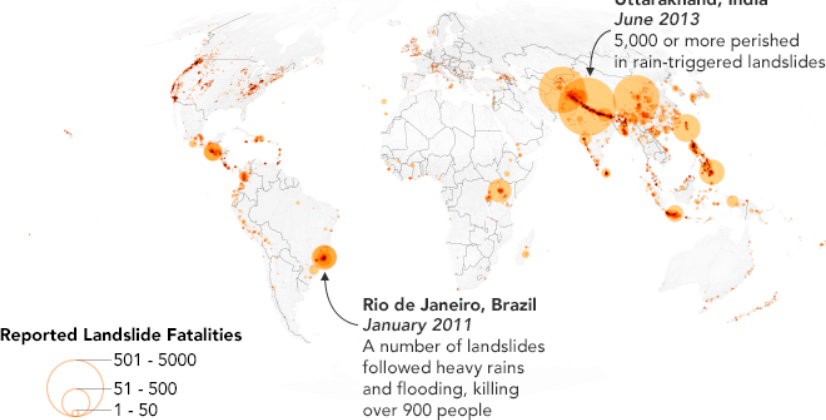
Figure 10. Map of 2085 landslides with fatalities as reported in the Global Landslide Catalog. Courtesy of NASA Earth Observatory, using landslide susceptibility data provided by T. Stanley and D. Kirschbaum (https://pmm.nasa.gov/articles/help-create-largest-landslide-database, last accessed 24 September 2019) [294,295].